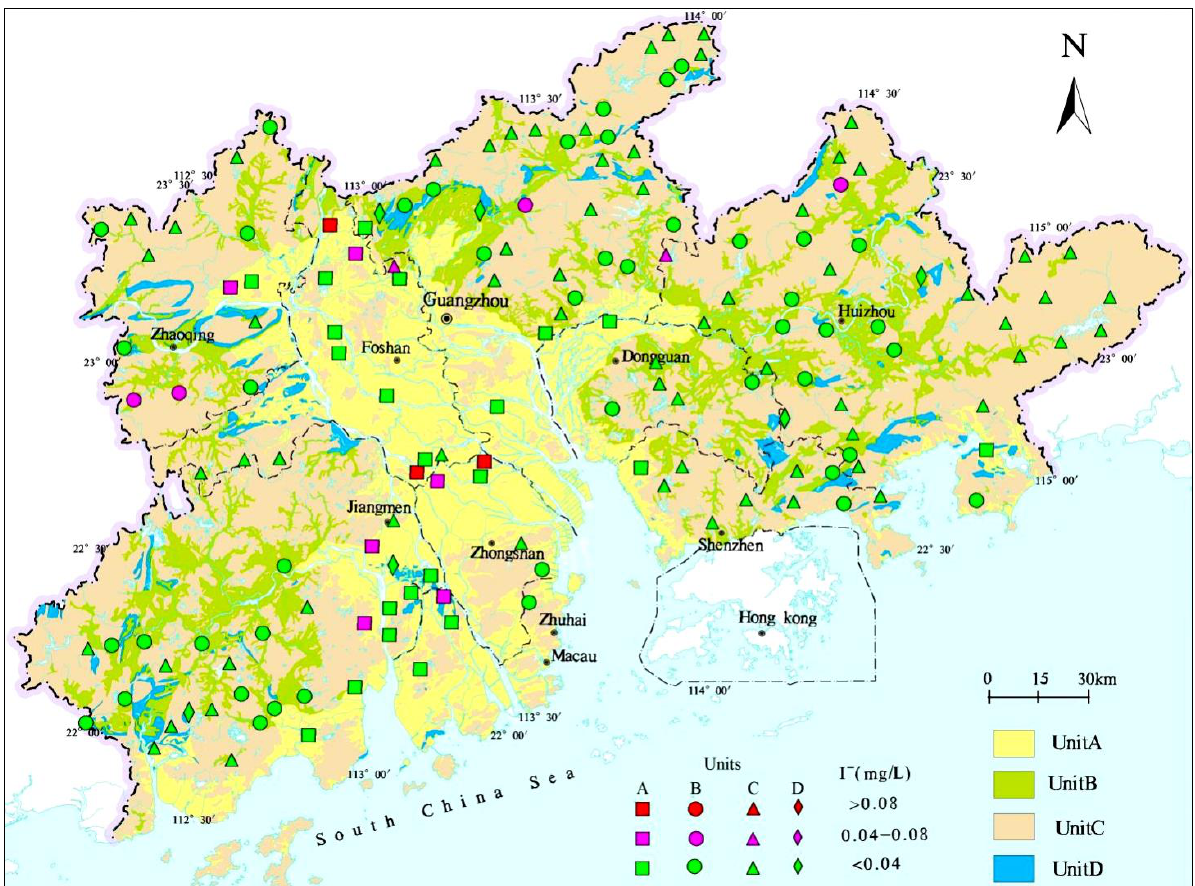
Figure 4. Distribution of I − in various groundwater units in the residual datasets.